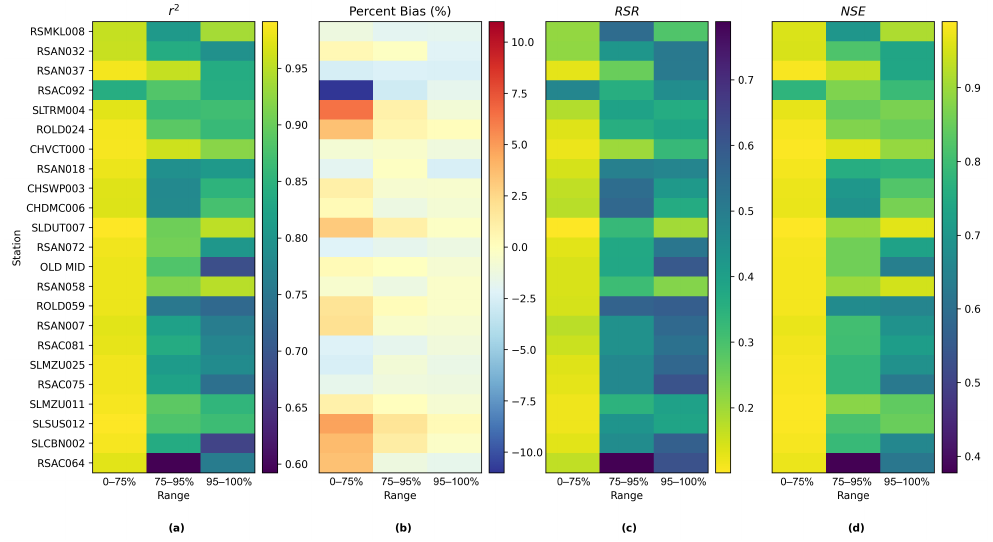
Figure 7. Heatmap showing Res-LSTM performance at different salinity ranges on the daily time step: low–middle range (lowest 75%), high range (75 to 95 percentile), and extreme high range (highest 5%) at the study